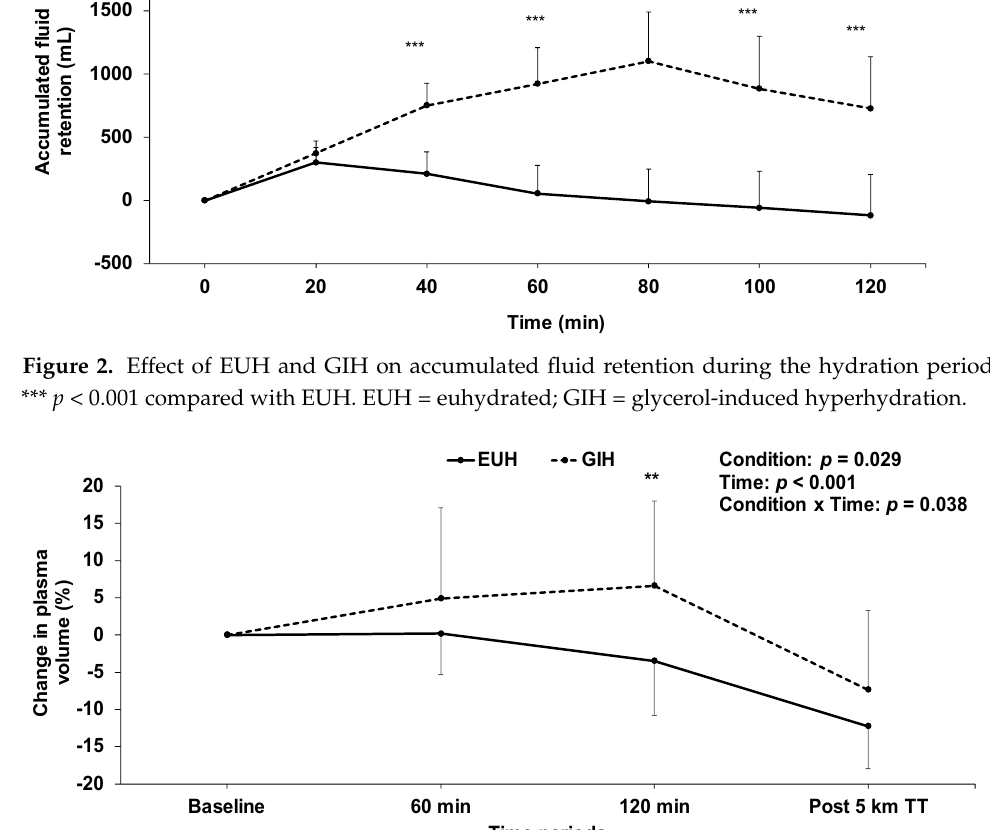
Figure 3. Effect of EUH and GIH on the changes in plasma volume over time during the hydration periods and time-trials. ** p < 0.01 compared with EUH. EUH = euhydrated; GIH = glycerol-induced hyperhydration; TT = time-trial.